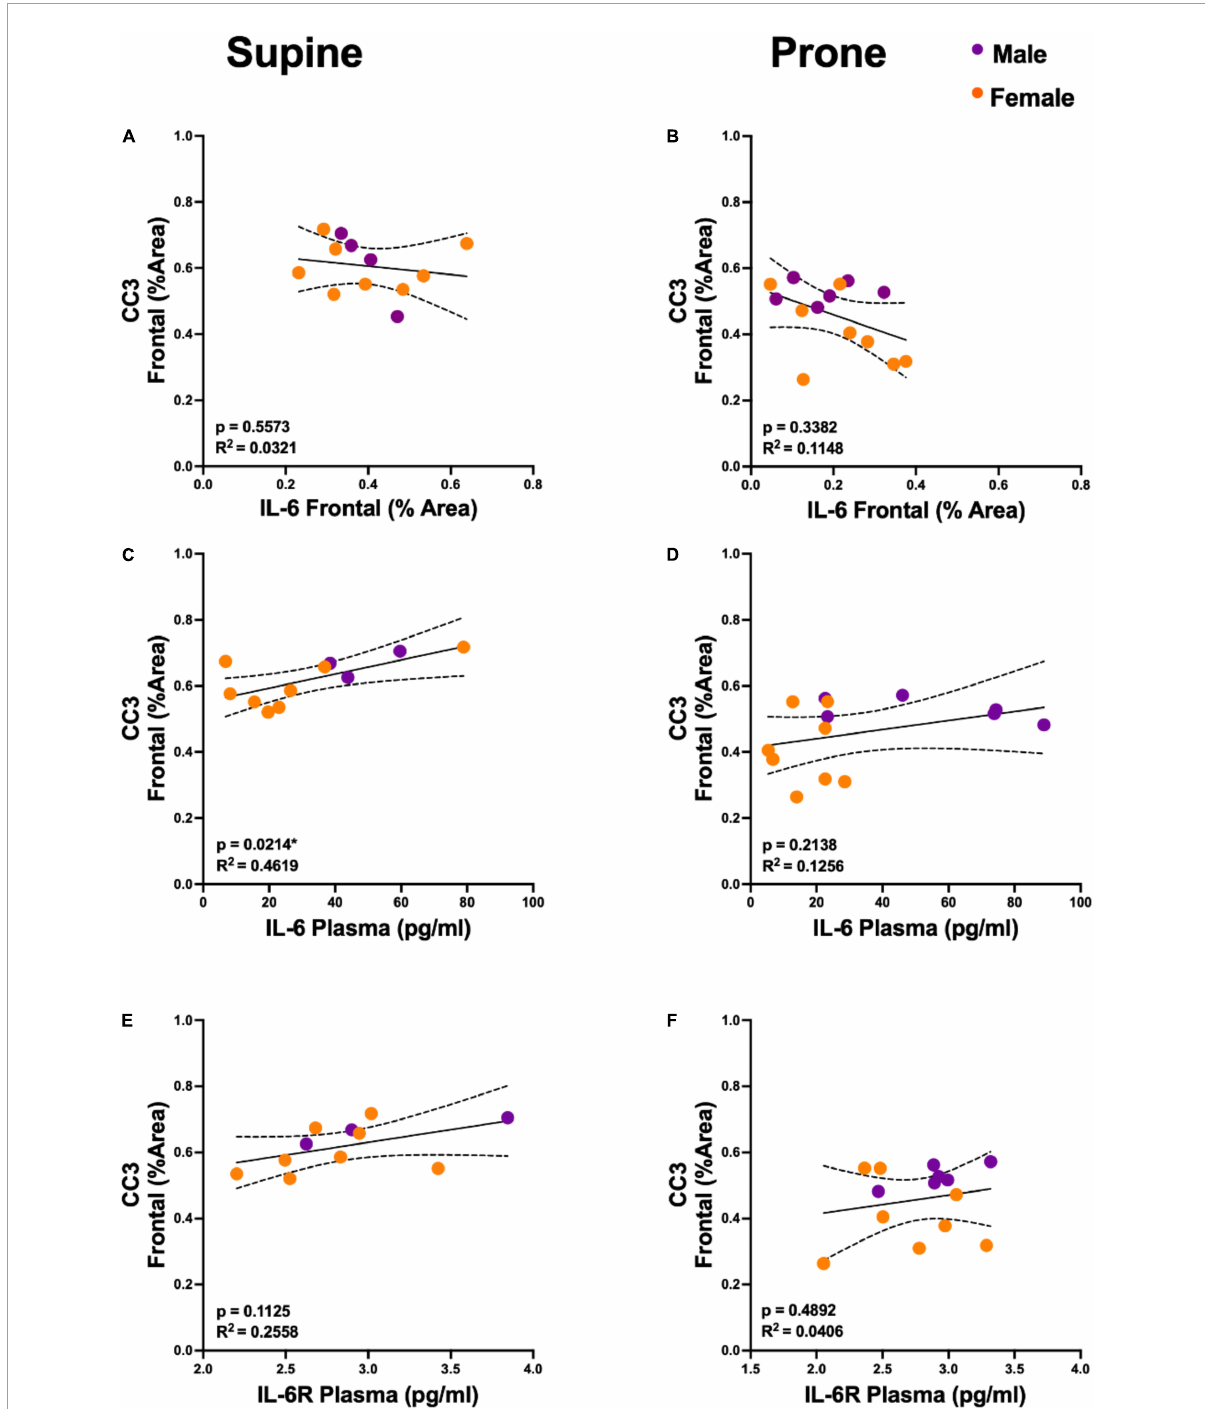
FIGURE4 Plasma interleukin 6 (IL-6) is predictive of cortical cleaved caspase-3 (CC3) levels, but only in the supine position. (A,B) Regression analyses demonstrated no statistically significant relationship between CC3 and IL-6 in the frontal cortex. (C,D ) Plasma IL-6 explained a significant proportion of variance in cortical CC3 in the supine group (R 2 = 0.4619, p = 0.0214) but not in the prone positioned group ( R 2 = 0.1256, p = 0.2138). (E,F) There was no significant relationship between CC3 and plasma IL-6 receptor (IL-6R) concentration. Group sample sizes for all analyses were prone ( n = 6, male; n = 8 females) and supine ( n = 4, male; n = 8 females). Sexes are color coded, but partial regressions were not utilized as we observed the same directional group (supine vs. prone) differences in both males and females. Dotted lines represent 95% confidence